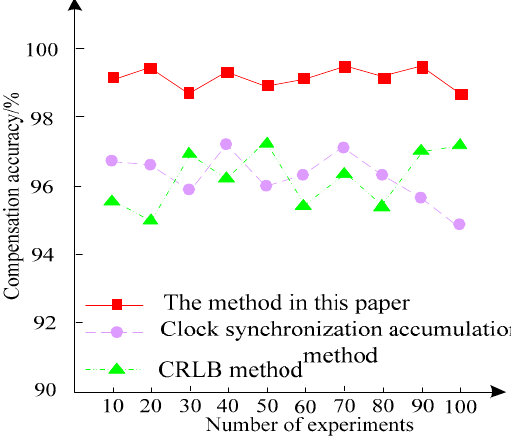
Figure 7. Comparison of compensation accuracy of three methods.